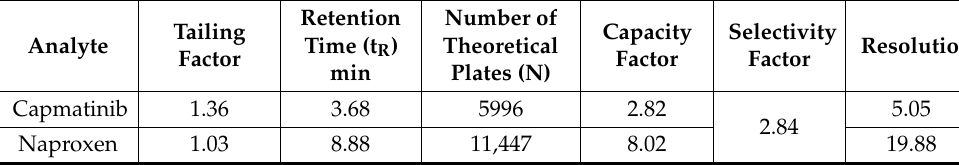
Table 2. Chromatographic parameters of the HPLC-PDA method.